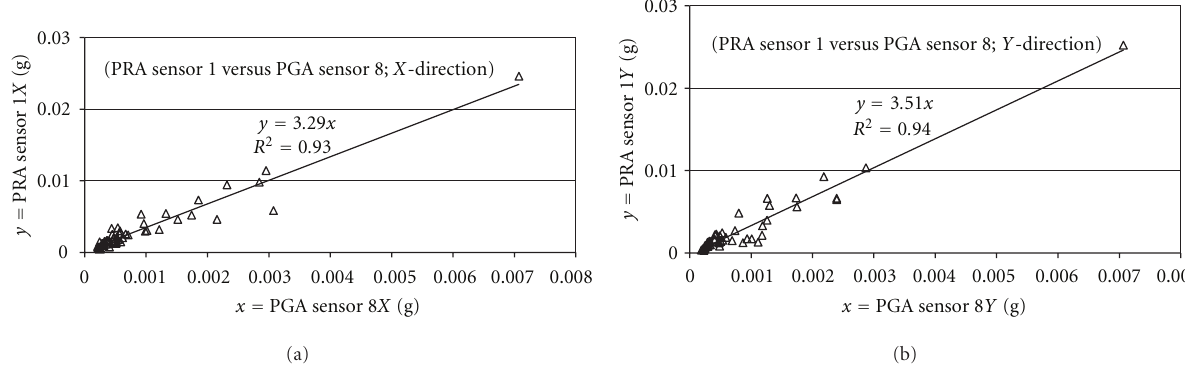
significantly between the di ff erent sensor pairs. The ranges of amplification factors were between 3.22 and 3.87, and between 3.27 and 3.52 for X - and Y -direction,